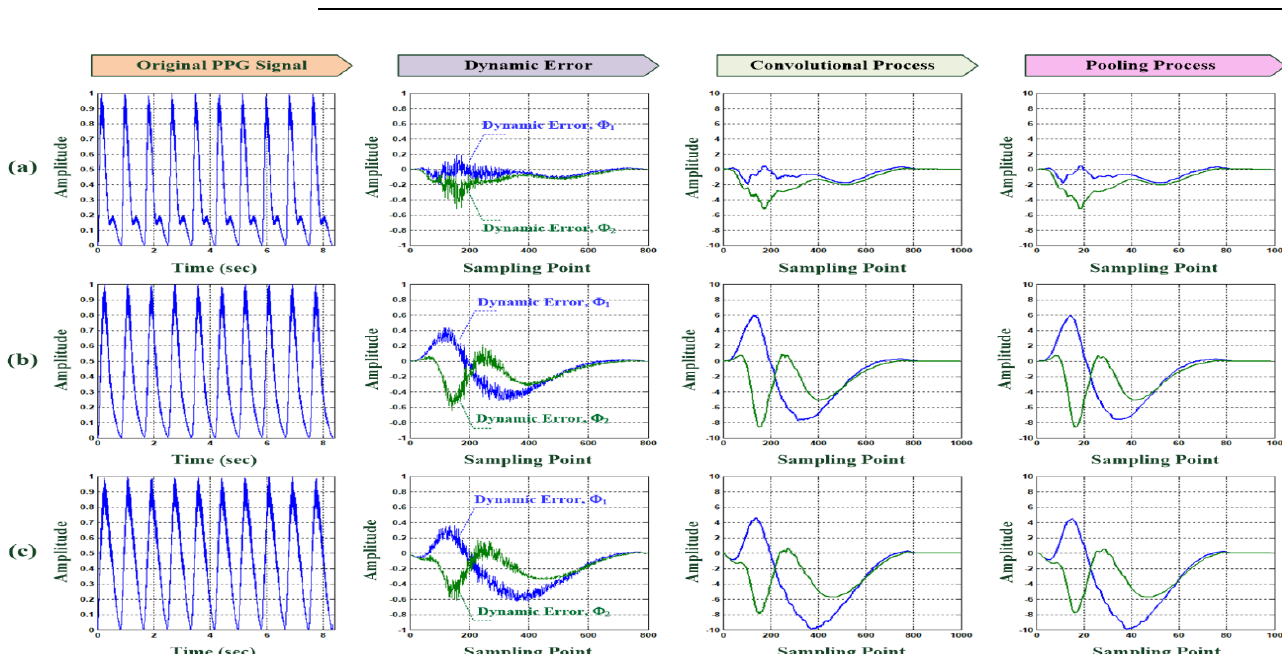
Figure 6. Original PPG stream data (10 cycles), self-synchronization dynamic errors (Φ 1 and Φ 2 ) for each cycle feature extraction, convolution-processed patterns for each cycle feature enhancement, pooling-processed patterns for reducing the pattern’s dimension for different PAD risk levels. ( a ) Nor, ( b ) LPAD case, and ( c ) HPAD case